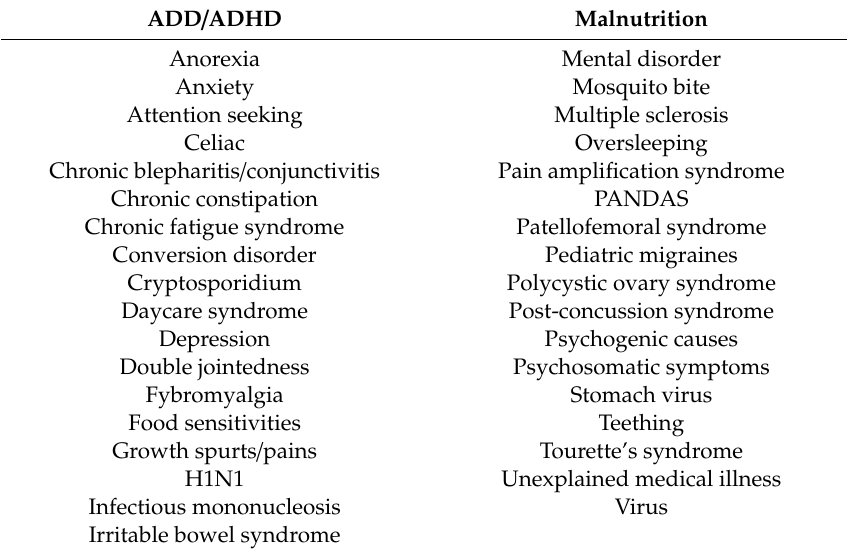
Table 4. Proposed